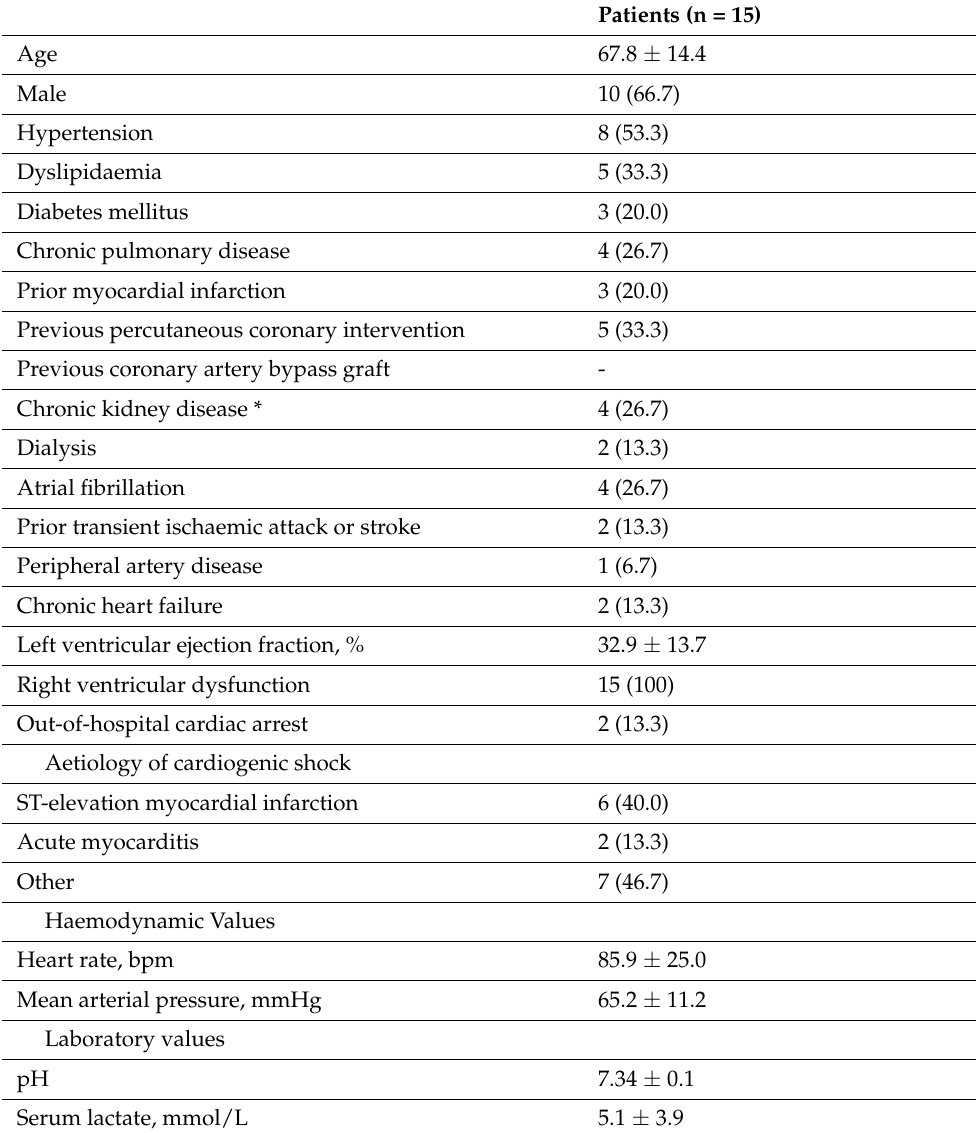
Table 1. Baseline characteristics and clinical